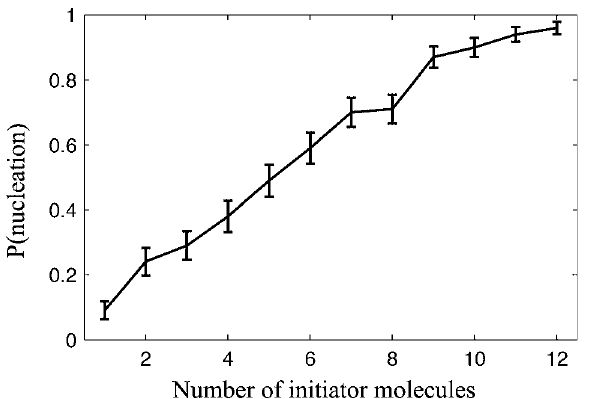
Figure 8. Probability for Nucleation as a Function of the Number of Initiator MinD mem Molecules The stochastic model with PE (cid:1) parameters was solved for a box (5 l m 3 1 l m 3 1 l m), with membrane on one of the 1- l m 3 1- l m sides. The simulations were initialized with a membrane occupancy of 1–12 MinD molecules. A total of 100 trajectories were gathered for each number (1– 12) of initiator molecules. The probability of nucleation is defined as the fraction of trajectories reaching more than 100 membrane-bound